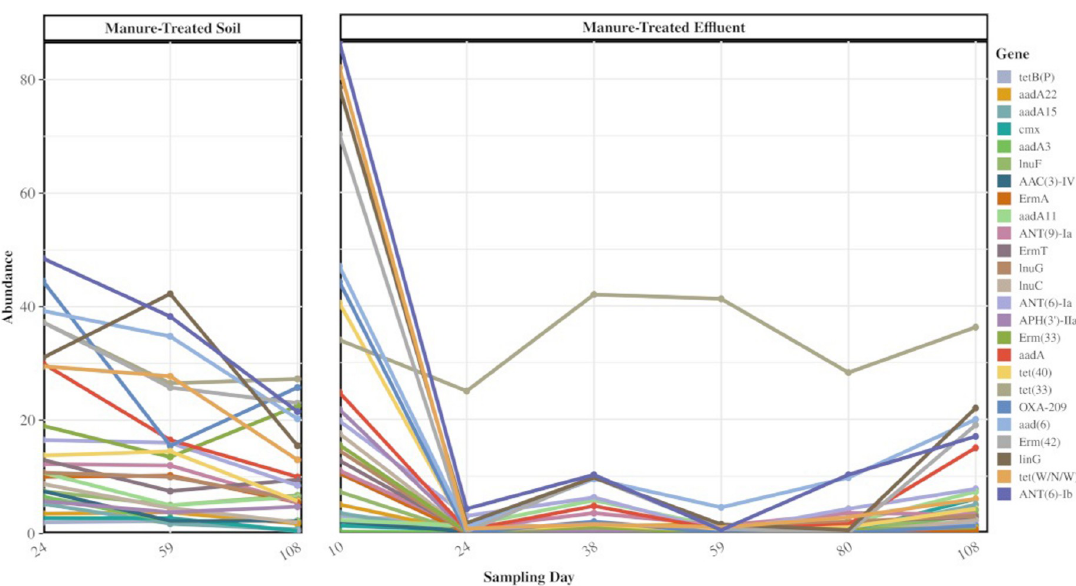
Fig 5. Abundance of 25 persister ARGs observed in manure-treated soil and manure-treated effluent samples in at least half of all samples after each rain event. Abundance is averaged for 4 replicate samples at each time point and normalized by number of recA genes present in each sample. tet(33) is highlighted, showing unique presence compared to the other persisters.